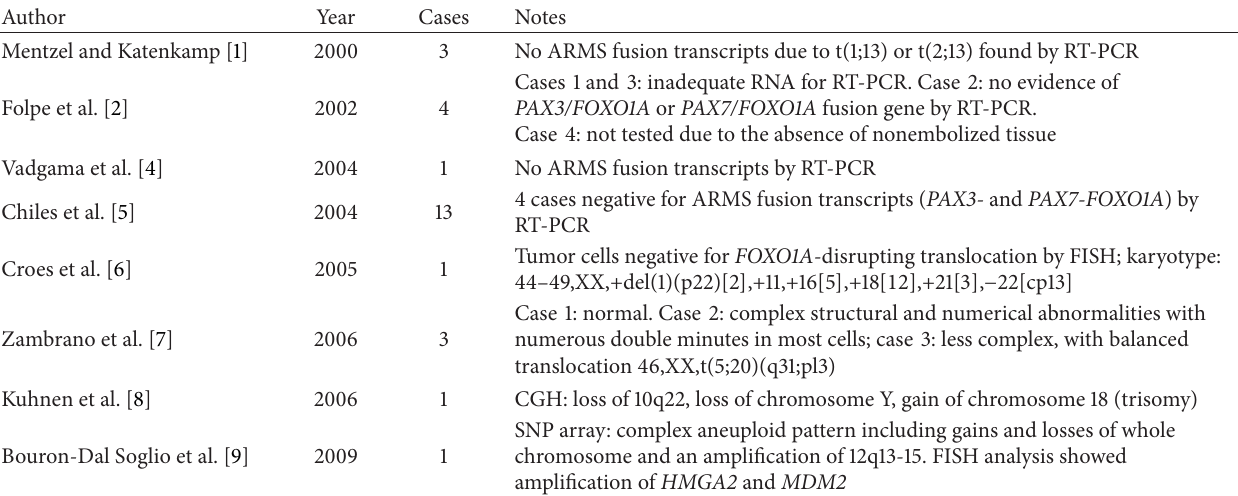
chromosome and an amplification of 12q13-15. FISH analysis